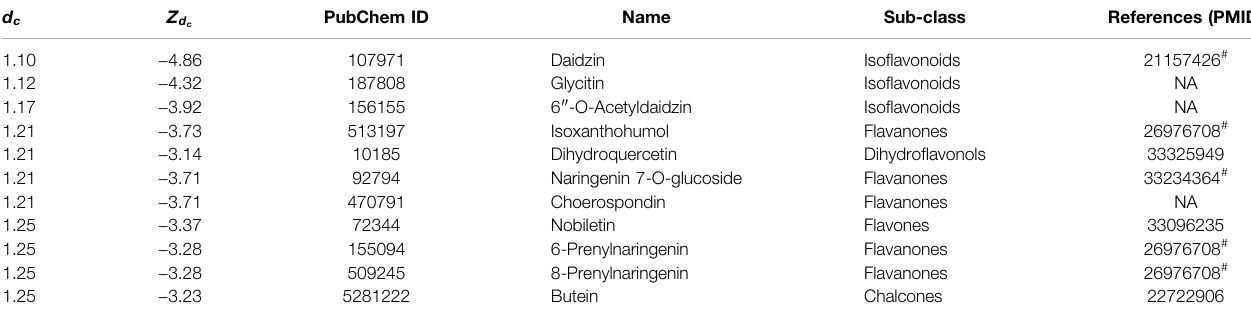
TABLE 1 | Top network-predicted candidate fl avonoids for NAFLD with available literature-derived evidence. d c